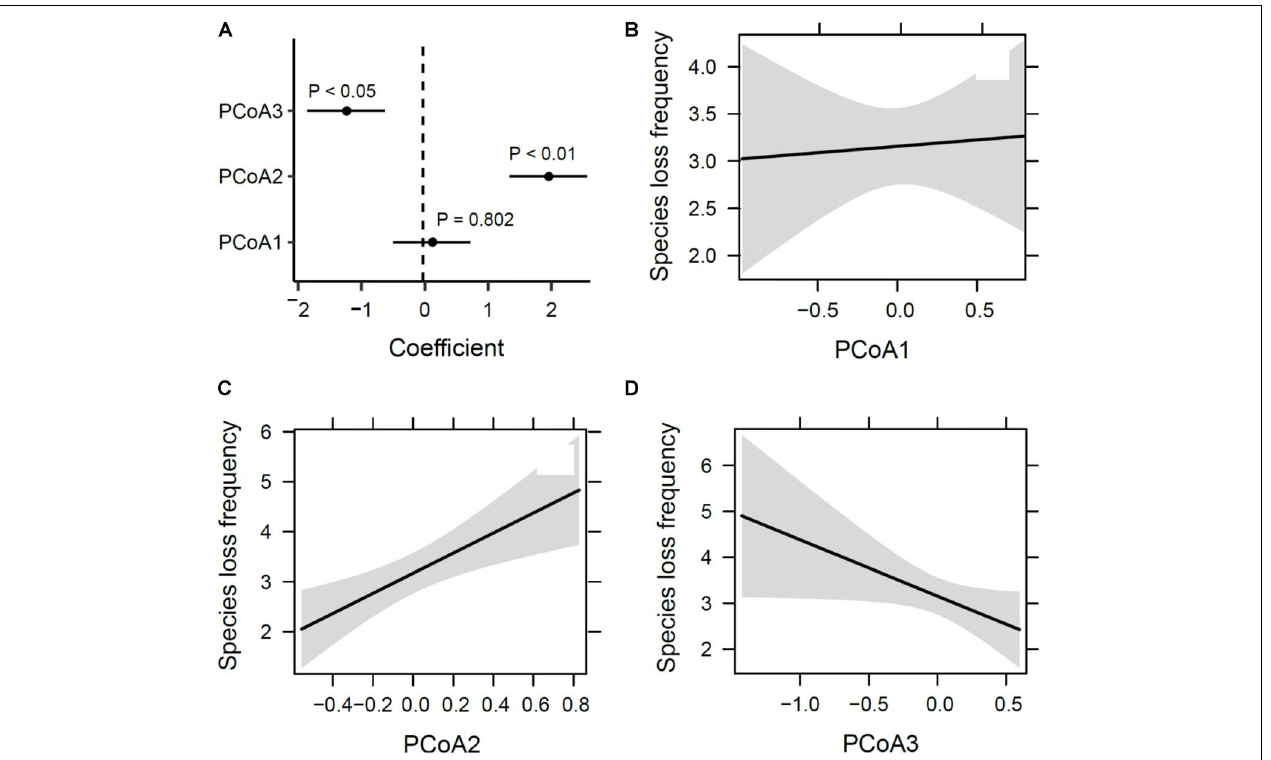
FIGURE 5 | Sensitivity of species loss to functional traits. (A) Correlation coefficients and their significance from a generalized linear model and panels, and (B–D) estimated marginal effects and confidence intervals of the first three PCoA axes (see Figure 3